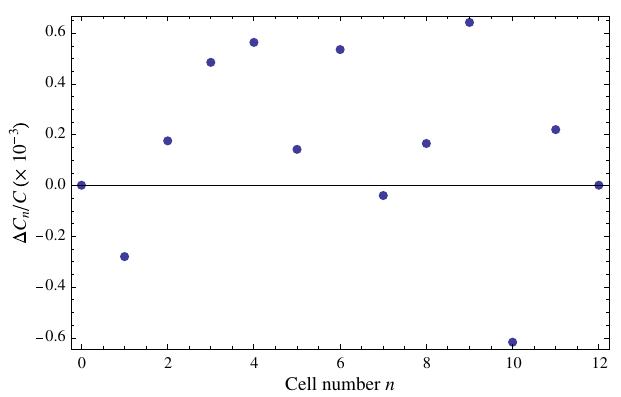
FIG. 13 (color online). The relative change Δ C n =C for n ¼ 1 ; :::::; 11 that is needed to minimize the difference between the predicted relative voltage and the measurements when tuning plates 3 and 9 are individually set to 20 mm. The results of the fit are shown in Fig. 14. Note, we did not use the effect of tuning plates 0 and 12 in the